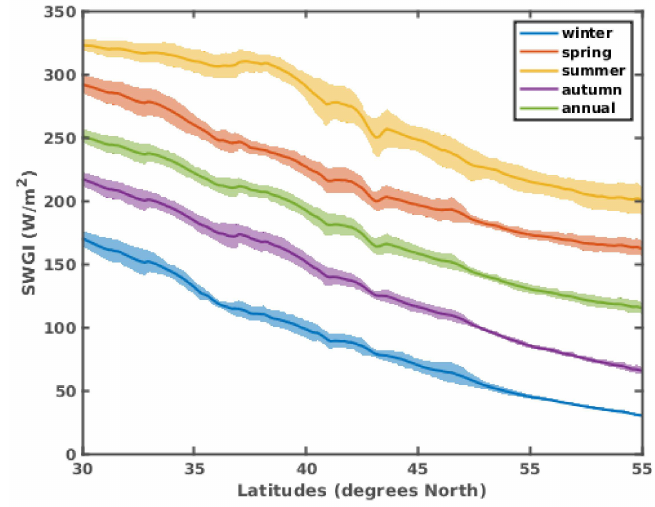
Figure 9. Latitudinal variability of SWGI over Euro-Mediterranean region for the period 1981–2020 from ERA5-Land. The shaded regions represent the spatial standard